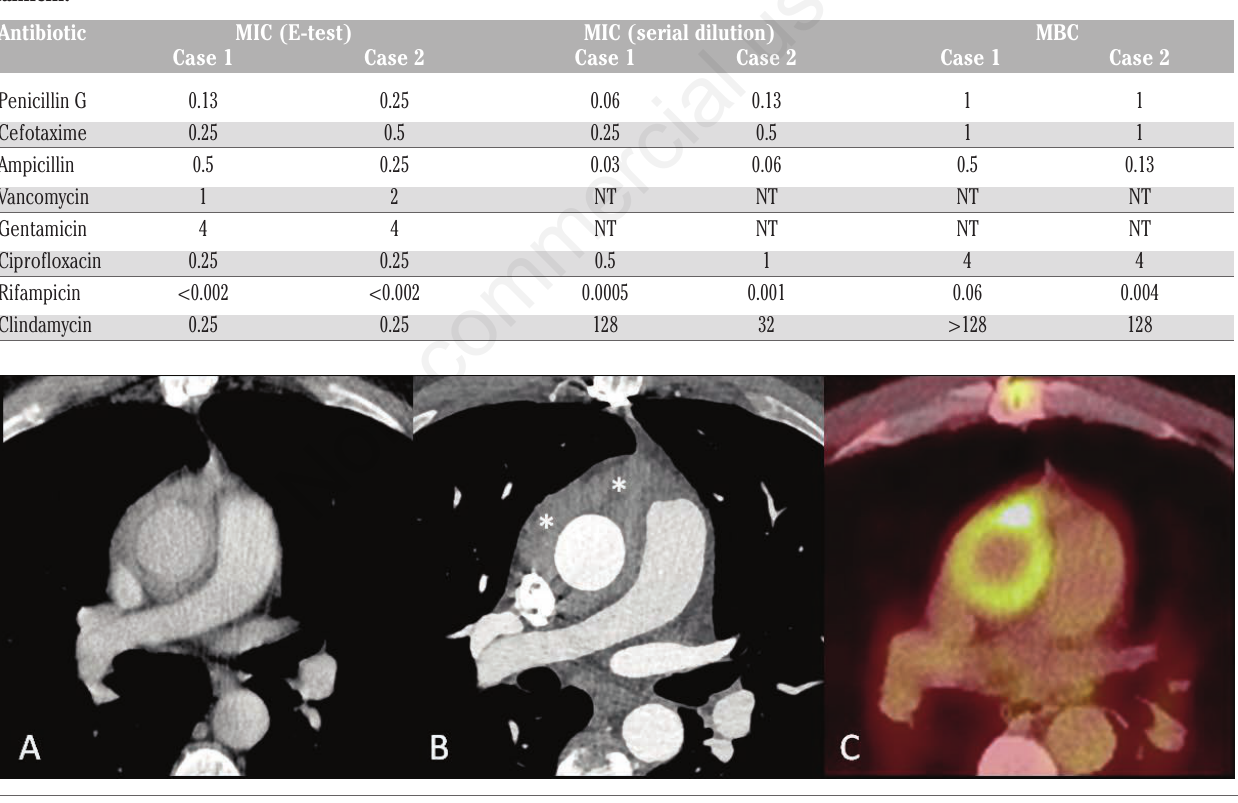
Figure 2. Transaxial images of the ascending aortic graft from three different time points. A) Contrast enhanced CT performed two months postoperatively shows a ring of soft tissue attenuation around the graft. In this early postoperative phase, it is difficult to dis- tinguish postoperative inflammation from infection. B) ECG-gated contrast enhanced CT three months postoperatively shows clear progression of areas of soft tissue attenuation around the graft (*) indicating infection. C) 18F-FDG PET/CT performed eleven months after the first CT scan shows increased 18F-FDG uptake circumferentially around the graft with a focal spot of high uptake ventrally in a region with soft tissue attenuation Increased 18F-FDG uptake in an early postoperative phase after aortic graft implantation or valve replacement can be due to normal postoperative inflammation and should be interpreted cautiously in the search for an infective process. However, in the present case 18F-FDG PET/CT was performed eleven months after surgery and the findings indicate persisting